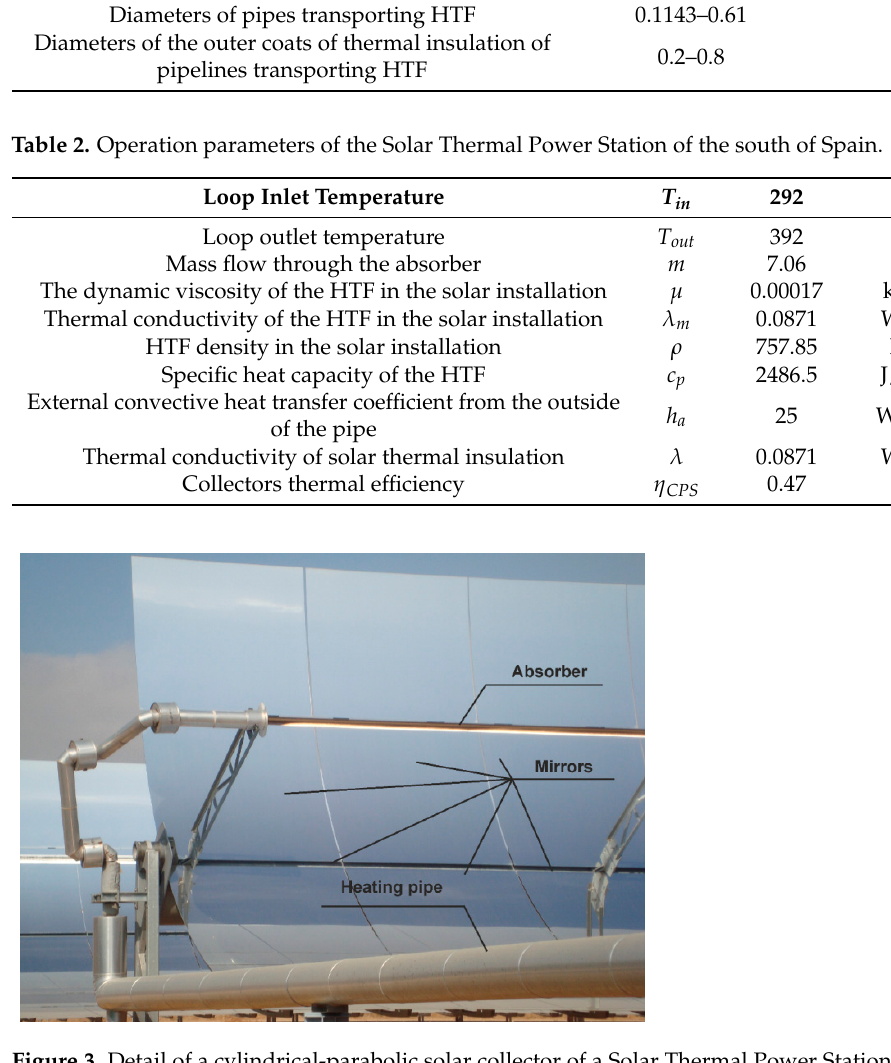
Figure 3. Detail of a cylindrical-parabolic solar collector of a Solar Thermal Power Station (photo by T.J. Teleszewski). Table 2. O peration parameters of the Solar Thermal Power Station of the south of Spain.